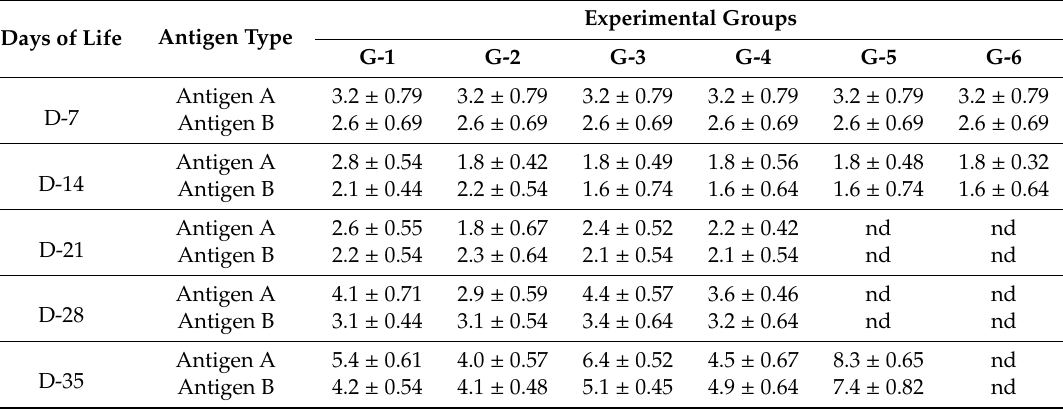
Table 4. Hemagglutination inhibition (HI) test results in bird groups (G-1-6) using